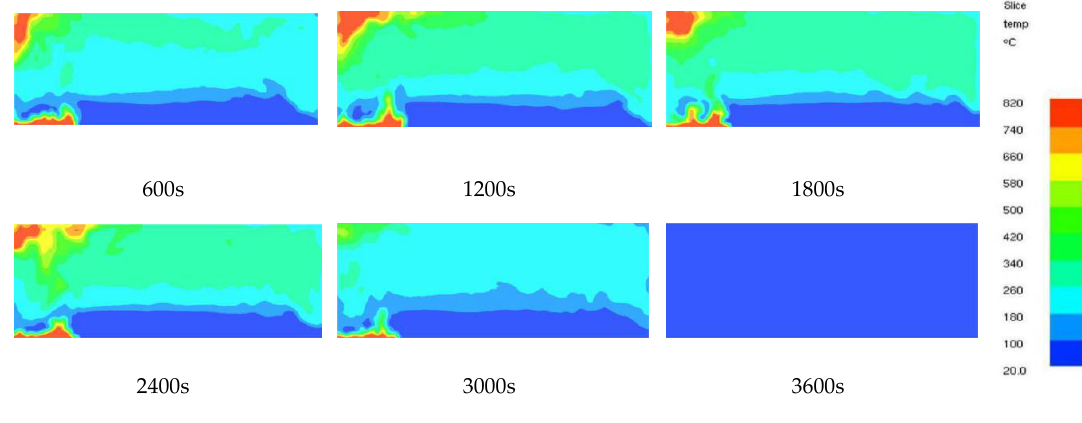
Figure 13. Slice temperature cloud (fire source location III).